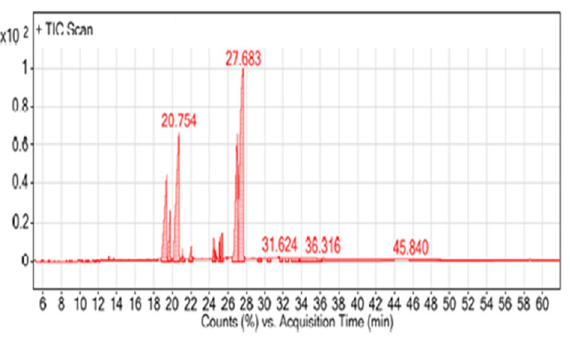
Figure 10. GC–MS chromatograph of the most effective fraction (the third fraction) of C. sinuosa methylene chloride